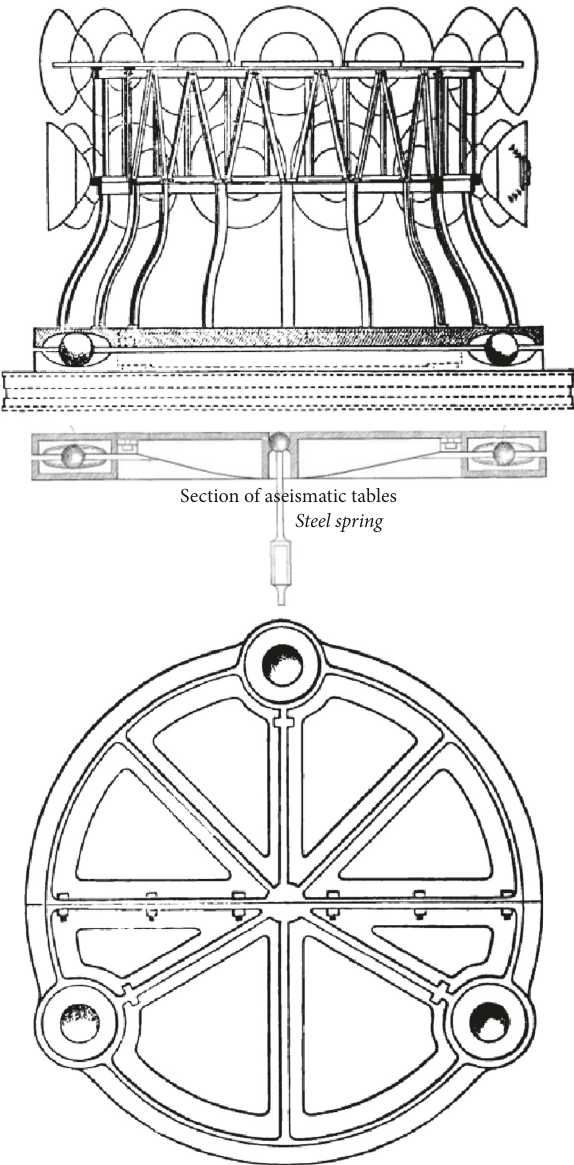
Figure 1: The aseismatic joint of Stevenson [1].